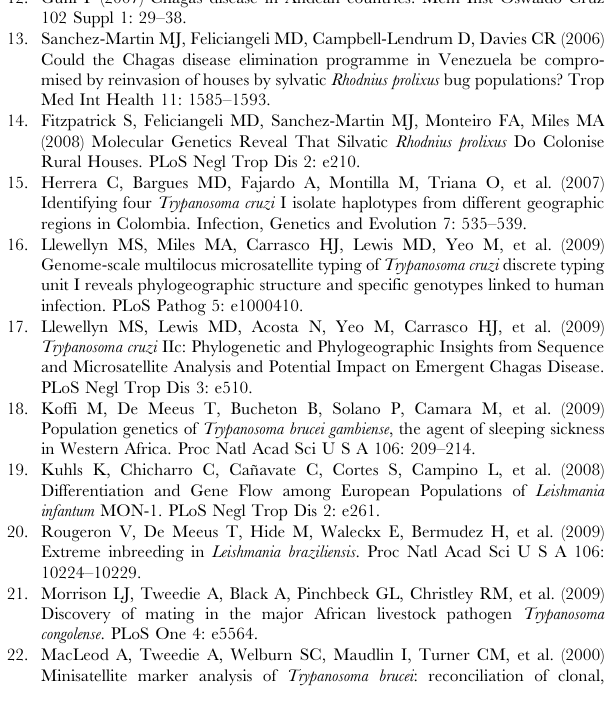
Figure S1 Clustering of populations based on STRUCTURE